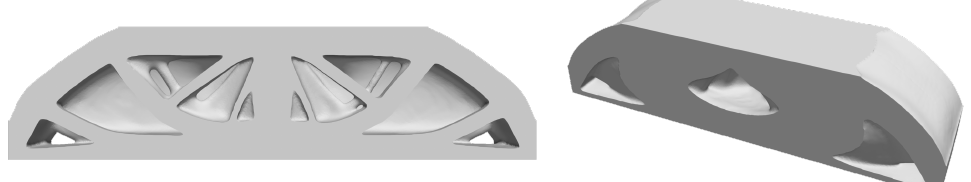
Figure 23. Derived design proposal of the standard topology optimization for optimization case 2: Sectional view ( left ) and overall view ( right